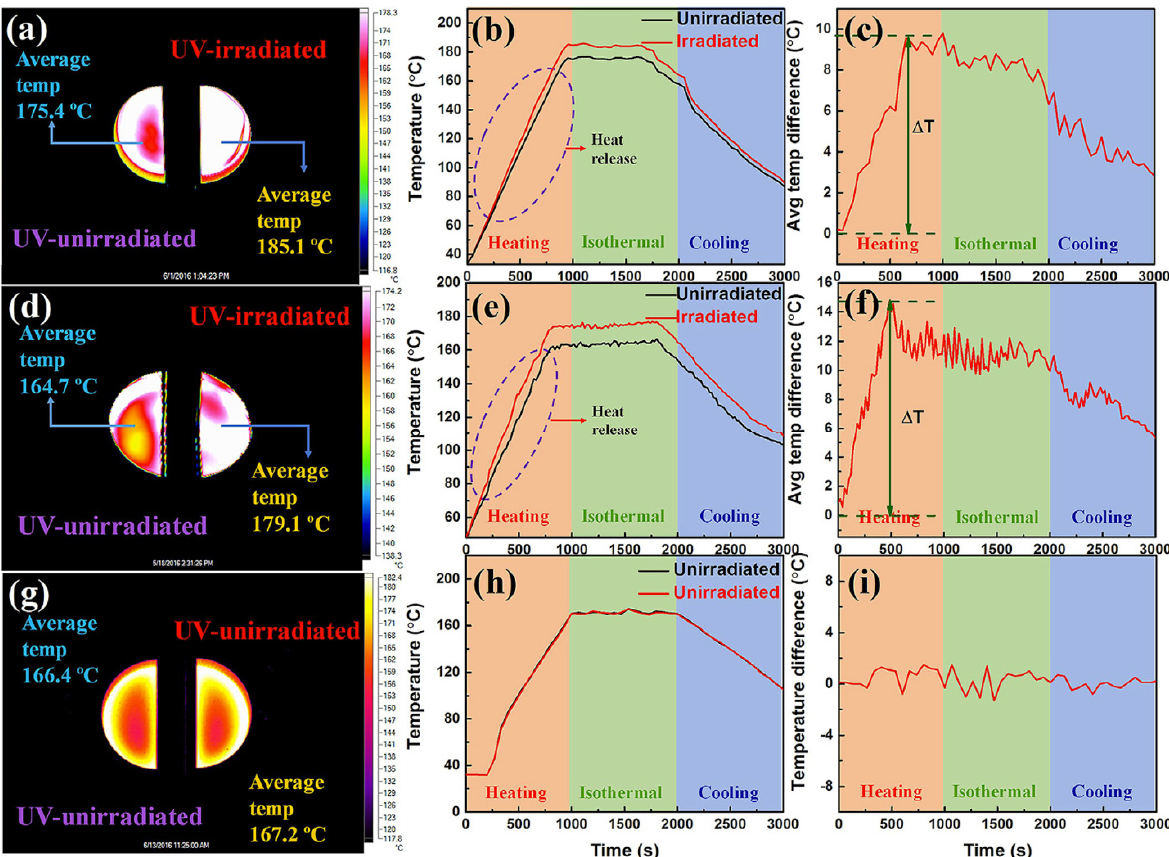
Figure 30. Macroscopic solid-state rGO–bisAzo heat release. First column: top-view IR heat map of films of ( a ) rGO–bisAzo-1, ( d ) rGO–bisAzo-2 with and without UV irradiation; ( g ) both semicircular rGO–bisAzo-2 films absorbed no UV light. The heat maps show the maximum rising temperature between areas; the color bar indicates the relative magnitude of the heat released. Second column: average temperature of ( b ) rGO–bisAzo-1, ( e ) rGO–bisAzo-2, and ( h ) unirradiated rGO–bisAzo-2 at different stages. Third column: average DT of ( c ) rGO–bisAzo-1, ( f ) rGO–bisAzo-2, and ( i ) unirradiated rGO–bisAzo-2. (Reprinted with permission from ref. [98]; Copyright @ 2017, John Wiley and Sons).